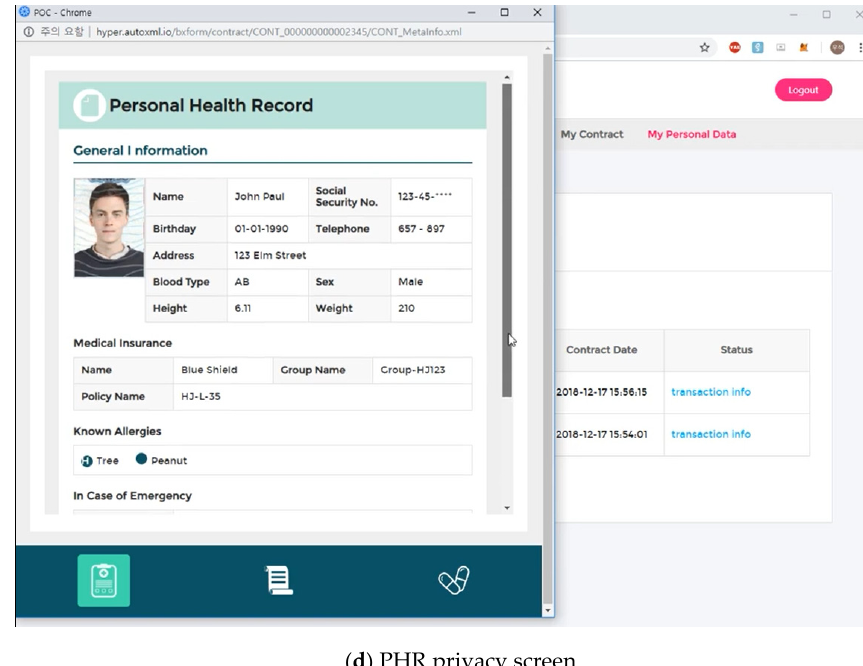
Figure 16. Blockchain PHR privacy screen using the neural network.